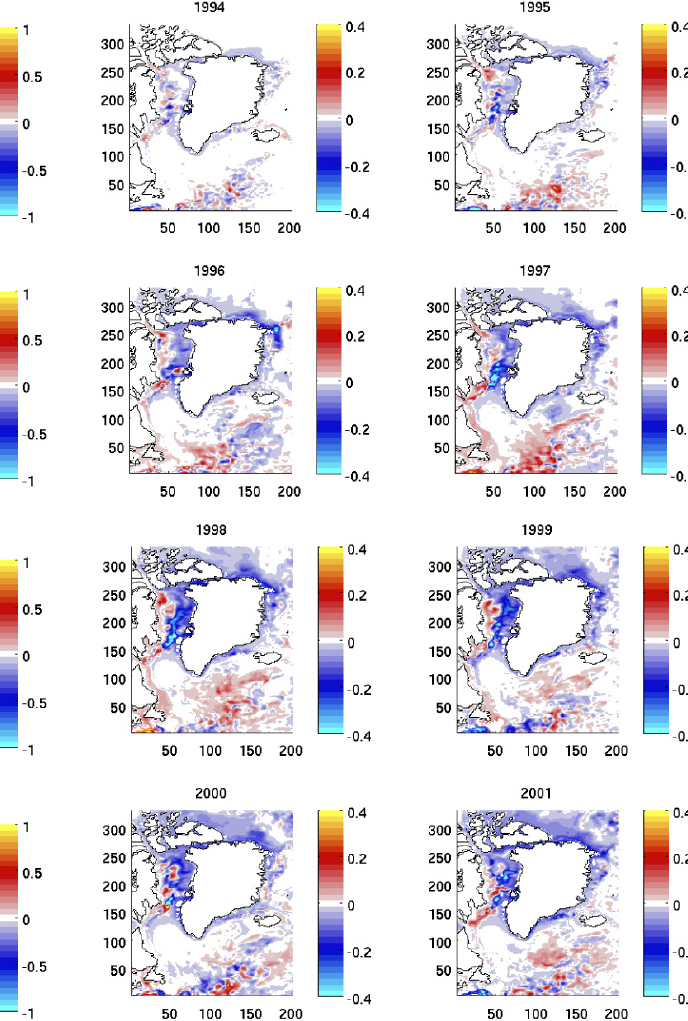
Fig. 9. Annual mean sea surface temperature anomalies ( ◦ C) for the period 1994–2001.